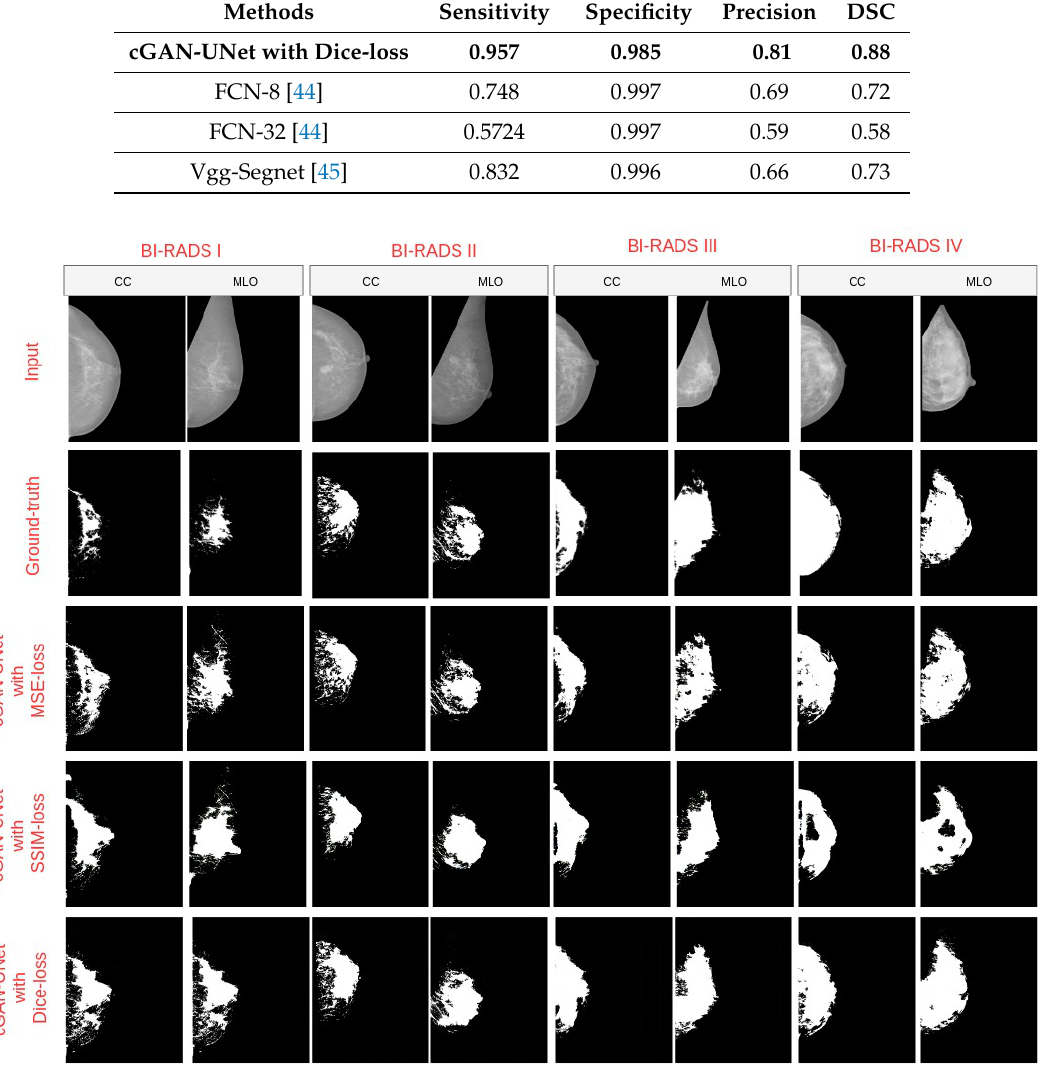
Figure 7. Breast density segmentation result of three models with the INbreast dataset. (Row 1) original images. (Row 2) Ground truth. (Row 3) Result of cGAN-UNet with dice-loss. (Row 4) Result of cGAN-UNet with myssim loss. (Row 5) Result of cGAN-UNet. (Col 1) BI-RADS I from two different views (CC and MLO). (Col 2) BI-RADS II. (Col 3) BI-RADS III. (Col 4) BI-RADS